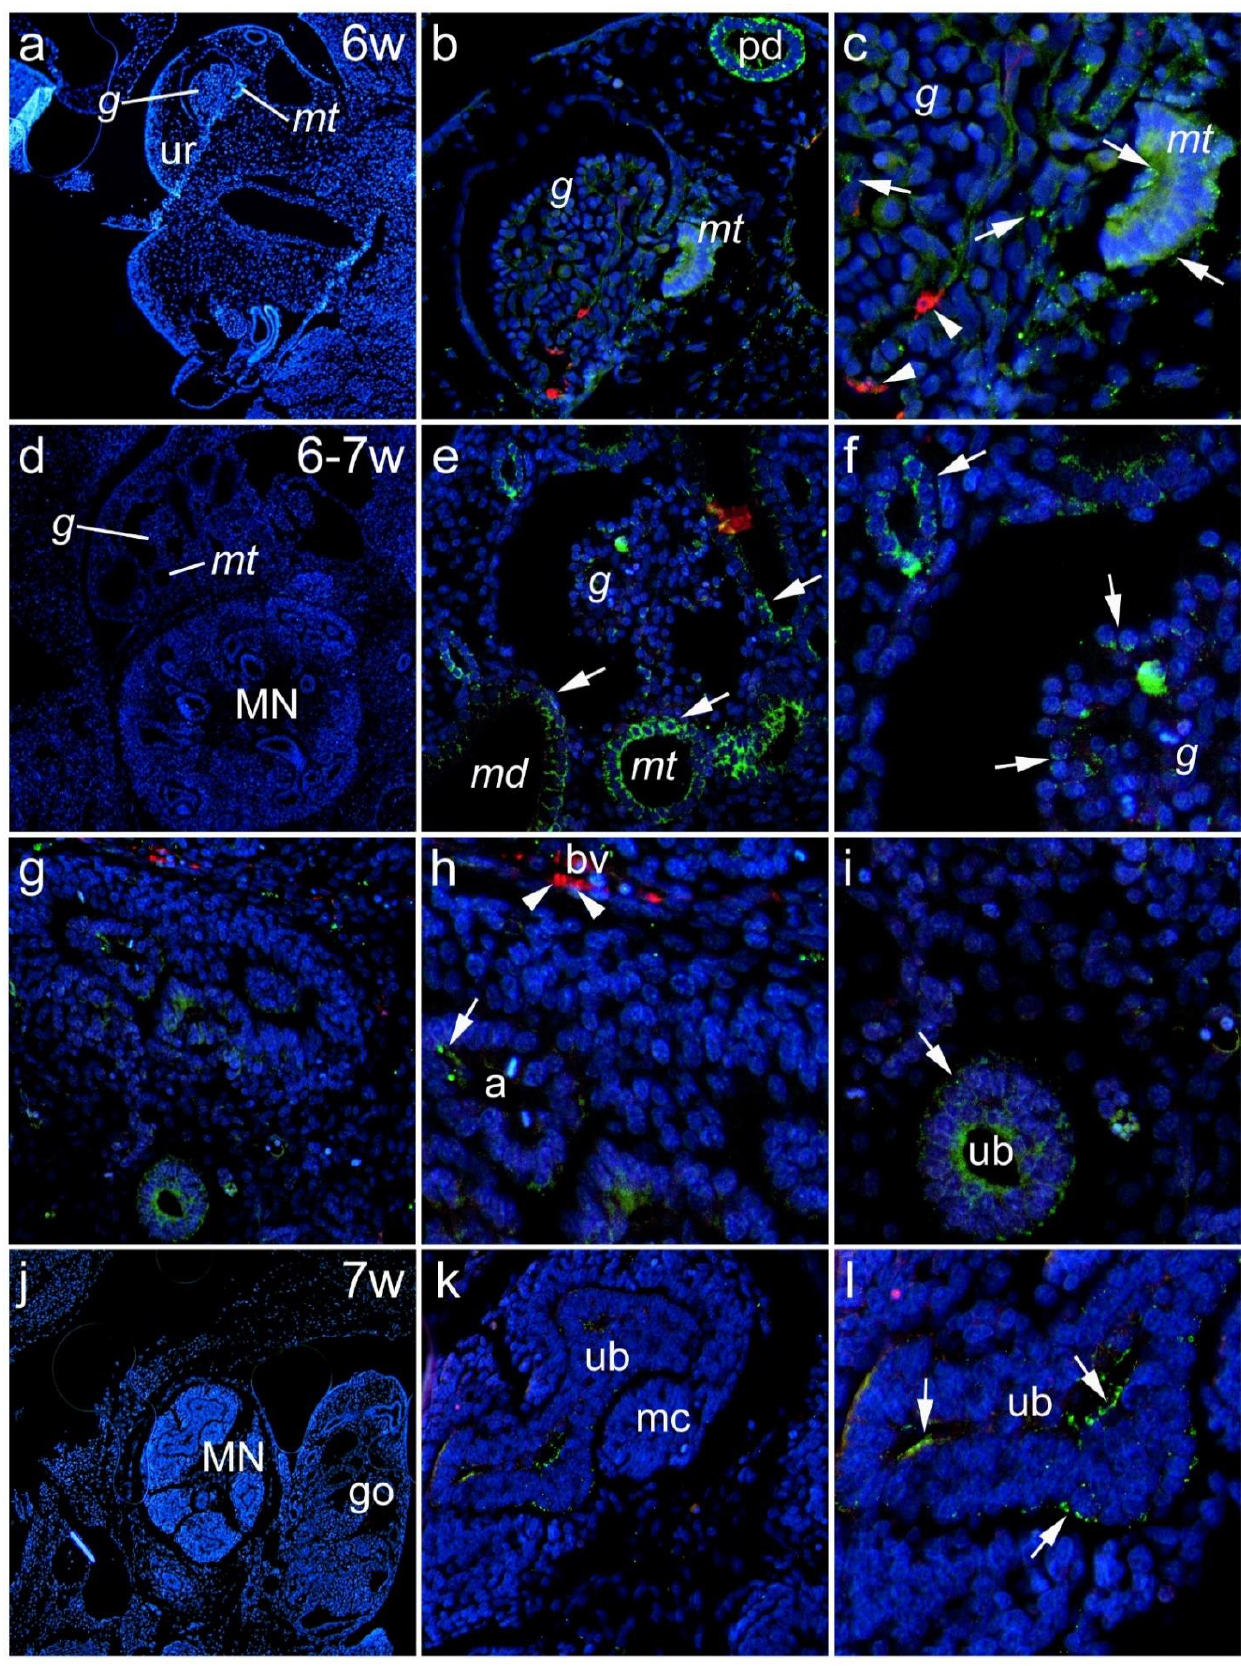
Figure 1. Expression of Panx1 during the 6th to 7th week of human renal development. During